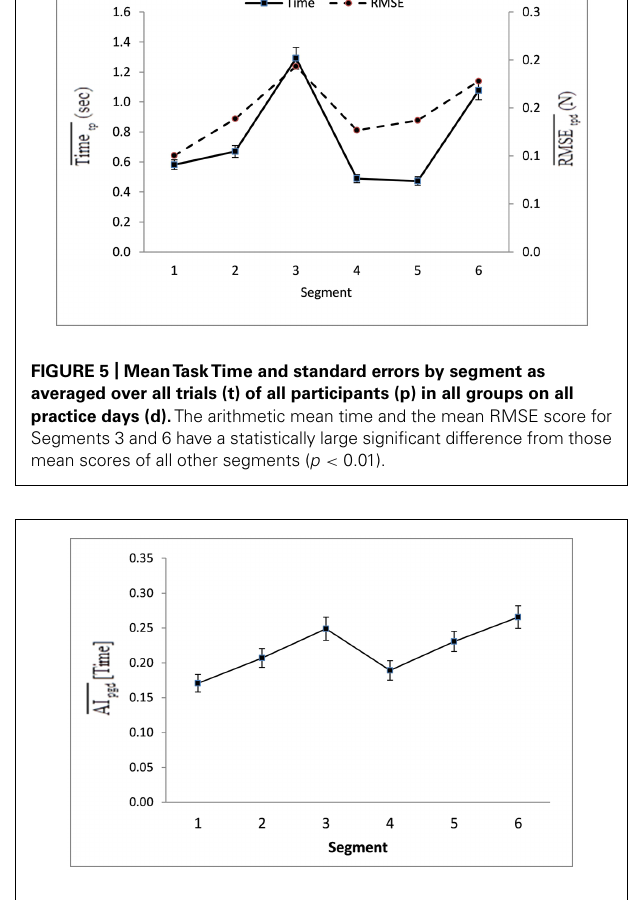
FIGURE 4 |Age group mean wholeTaskTime scores by practice day as averaged over all trials (t) of all participants (p). There was a statistically significant difference between the arithmetic mean time score for theY20 vs. O80 groups on Days 4 and 5 ( p < 0.05).